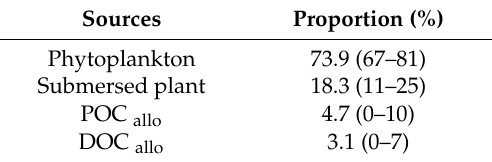
Table 3. IsoSource modeling results, based on ∆ 14 C and δ 13 C values, showing the proportional % contribution of the four carbon sources to the Lake Nam Co zooplankton given as mean and (1–99)